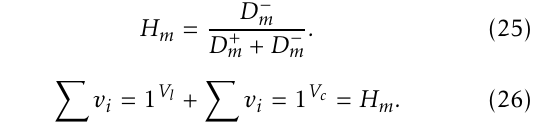
Algorithm 2 optimally partition the application into Algorithm 1: MATOA